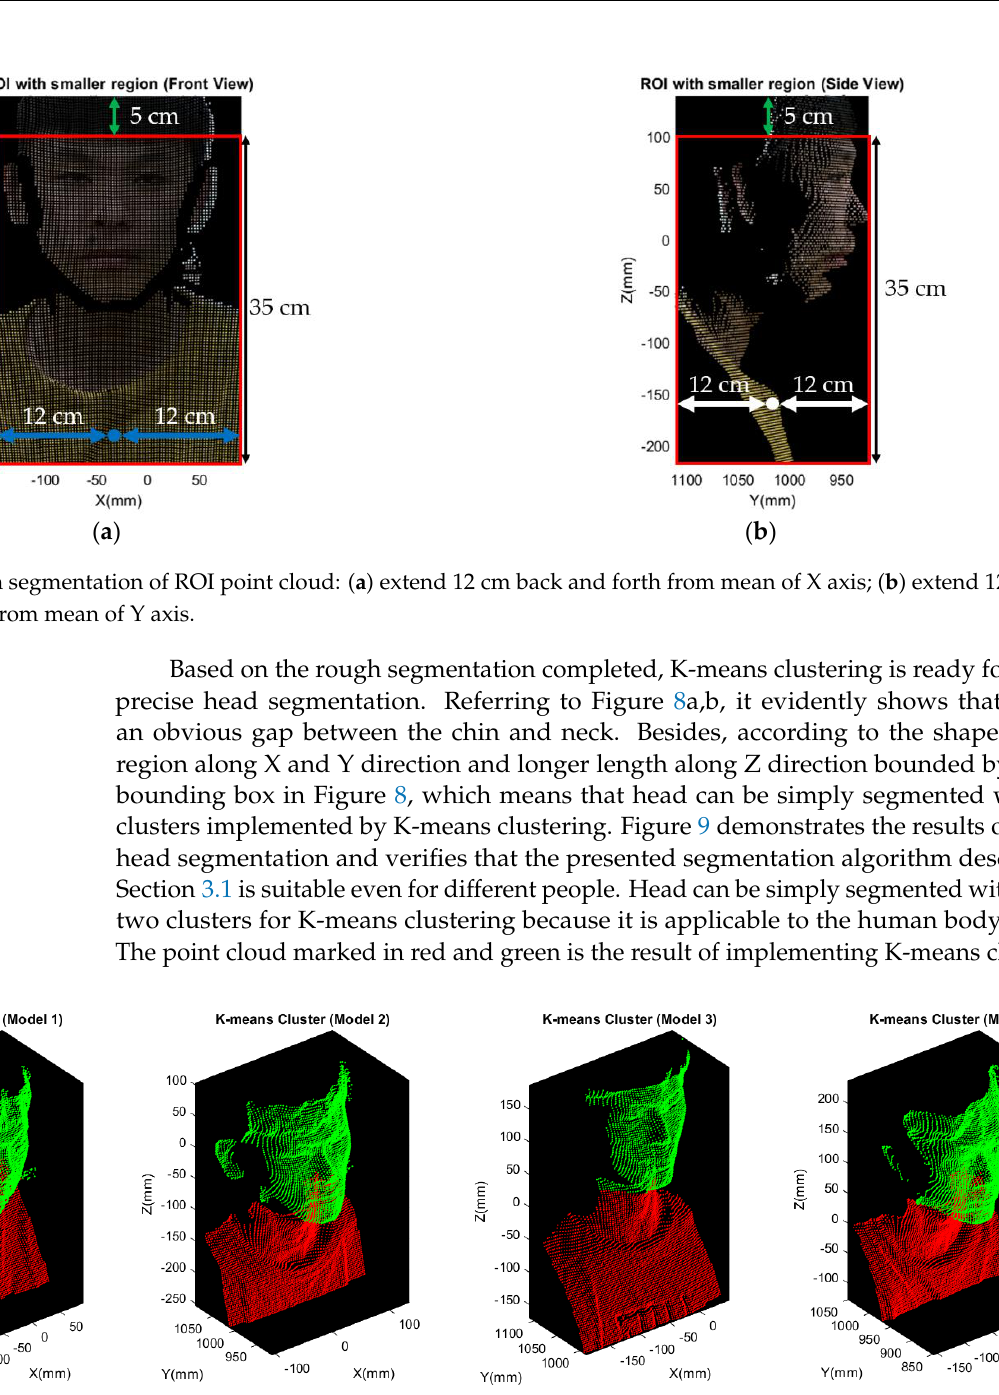
( c ) Figure 10. Multi-view nose tip detection, all nose tip is marked as red point: ( a ) nose tip of A point cloud (front view); ( b ) nose tip of B point cloud (turn left 30 degrees); ( c ) nose tip of D point cloud (turn right 30 degrees).